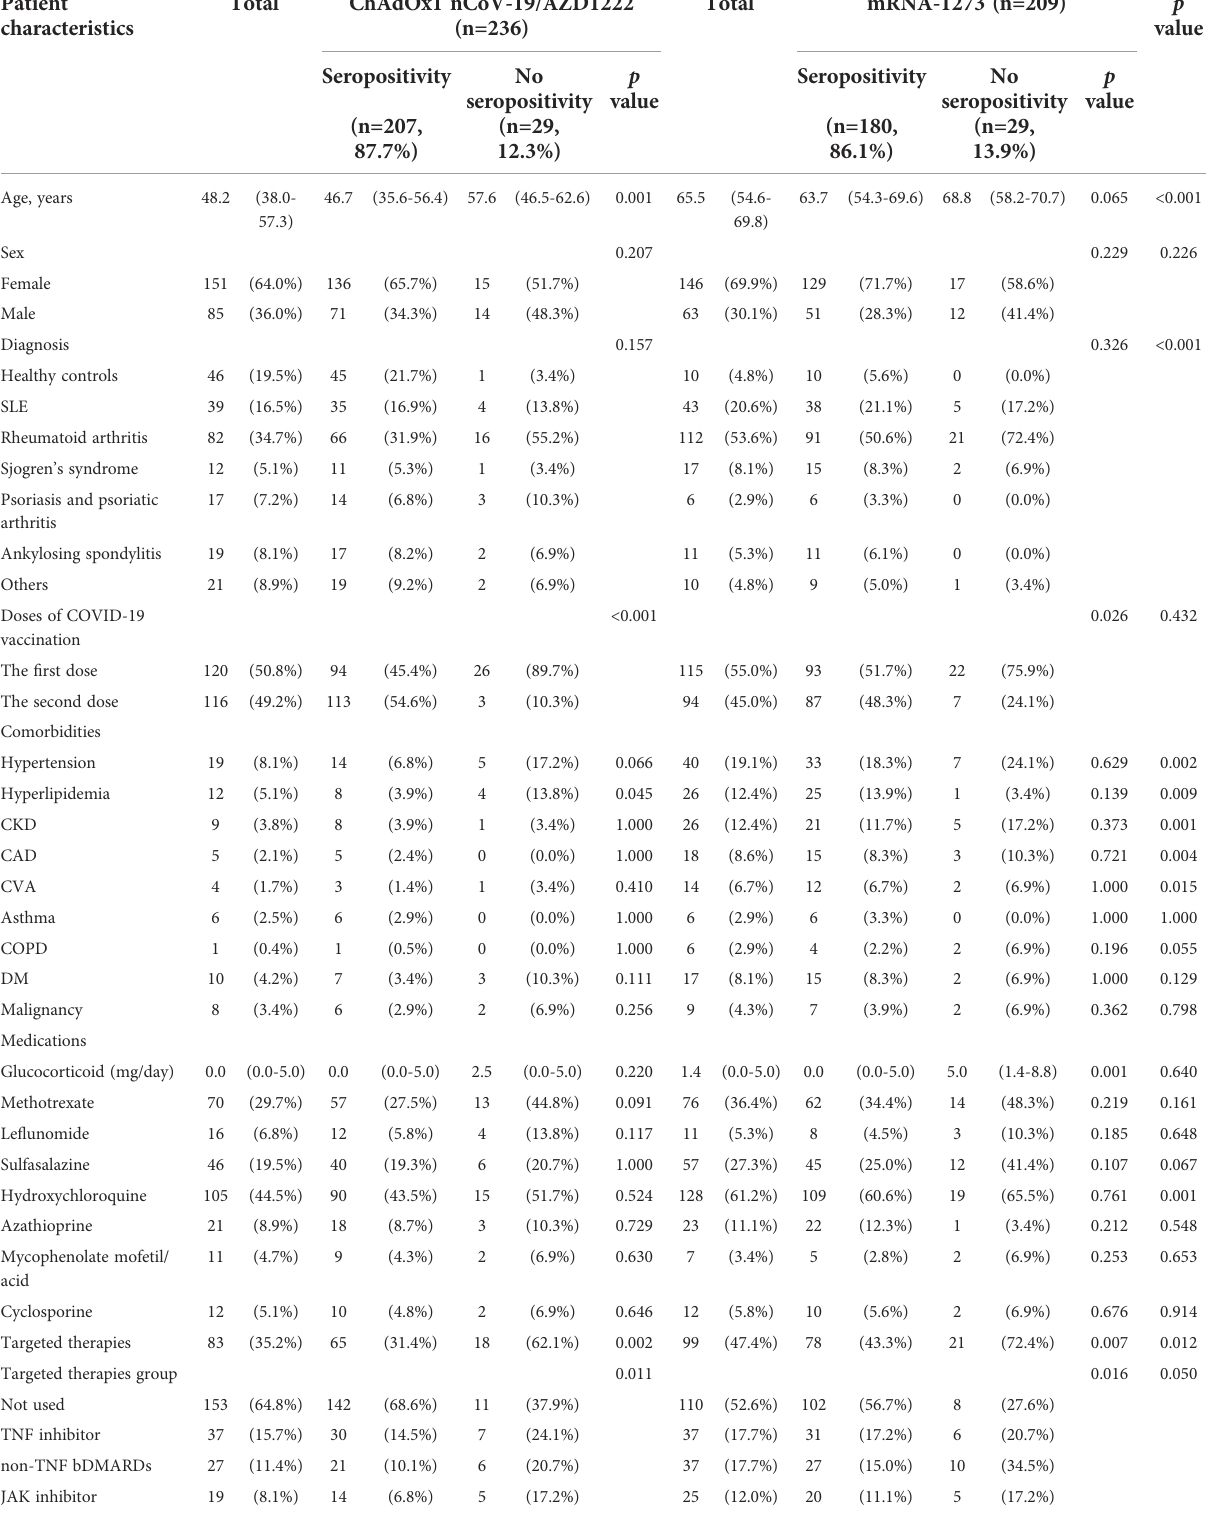
TABLE 1 Demographics and comorbidities of patients with rheumatic diseases following the fi rst dose of COVID-19 vaccines. Patient